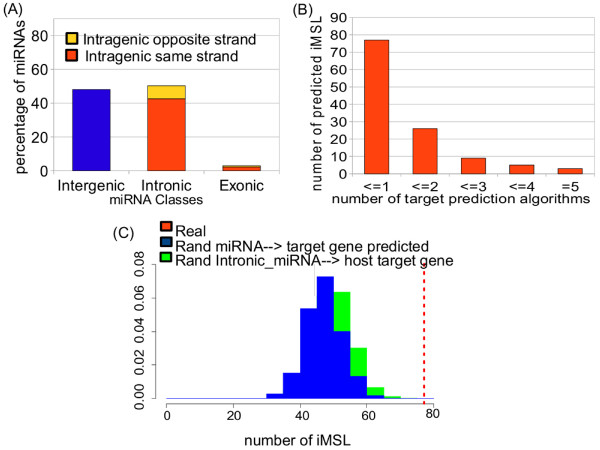
Classification of miRNAs and randomization results.(A) Classification of human miRNAs based on the percentage of intergenic and intragenic miRNAs. Intragenic miRNAs are divided in exonic and intronic miRNAs and each group can be further classified as same strand or opposite strand. All UTR miRNAs were included in the group of the exonic miRNAs. Data are reported in Table S1 of Additional file
1. (B) Number of intronic miRNA-mediated self-loops as a function of the number of target prediction methods in agreement: we found a total of 77 iMSLs predicted by at least one prediction methods, 25 of them are predicted by at least two different methods and only three of them are predicted by 5 different methods. (C) Results of the permutation test: the number of iMSLs in the human network is plotted as a dashed line alongside the distributions (normalized histograms) of the number of iMSLs found using the two randomization strategies (described in the main text) over 1000 experiment repetitions.